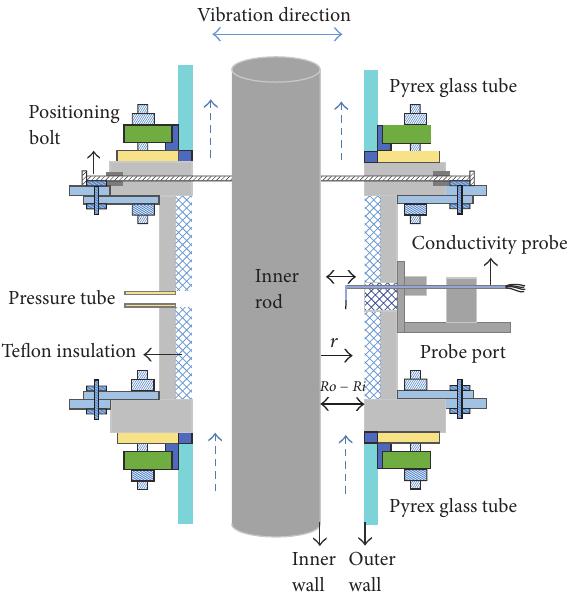
Figure 2: Measurement